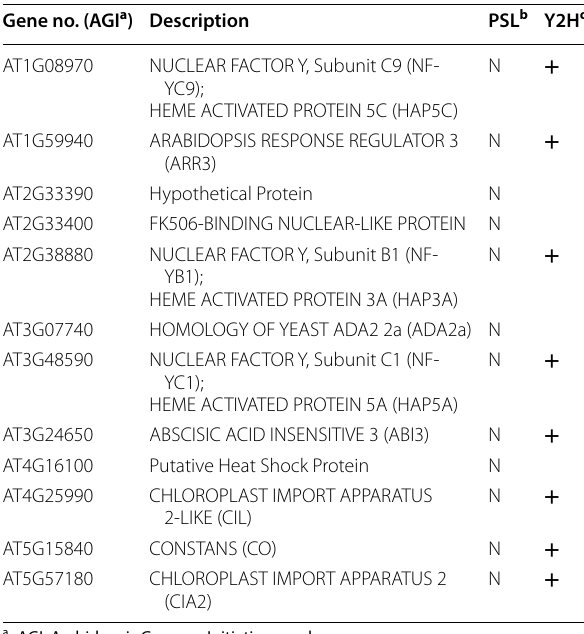
a AGI, Arabidopsis Genome Initiative number b PSL, Predicted subcellular localization based on SUBA3 database (Tanz et al. 2013). N, nucleus c , subjected to Y2H assay +